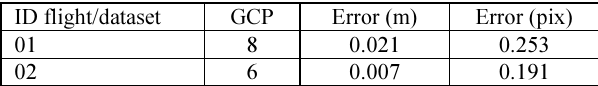
Table 5: Residual error of GCPs estimated positions by PhotoScan